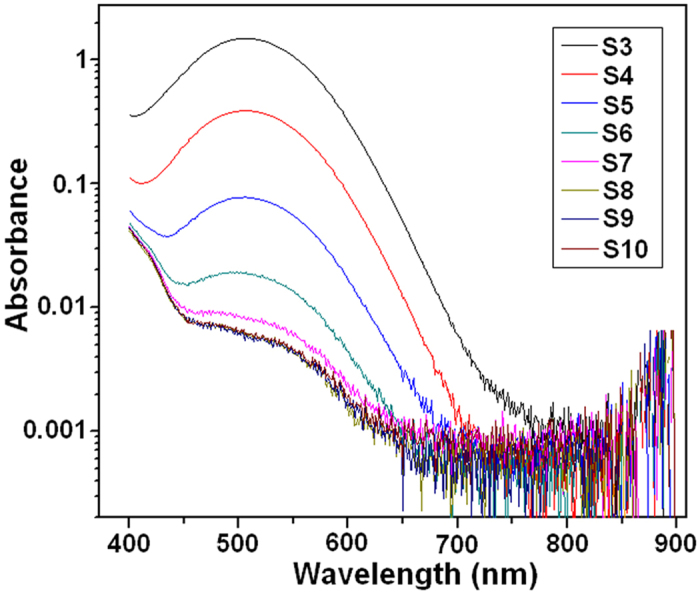
Measurement results of glucose samples by using the spectrophotometer.